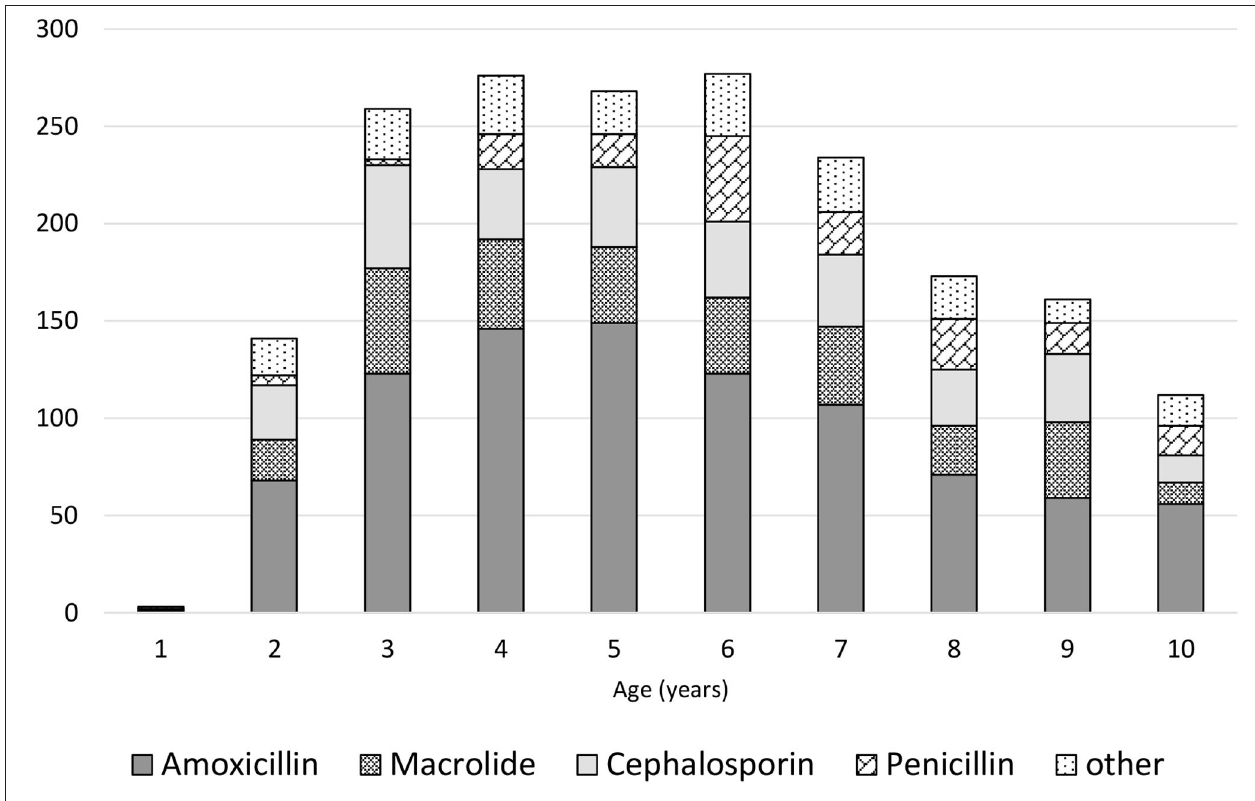
FIGURE 1 | The types of antibiotics used depend on the age of the children. TABLE 2 | Antibiotic therapy and selected environmental factors in the study group ( n =